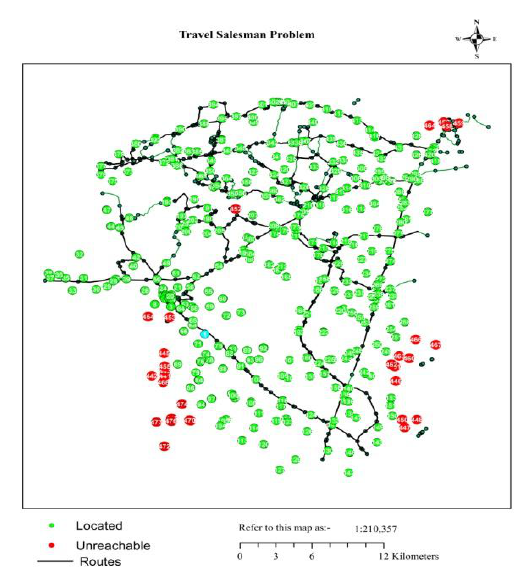
Figure 14. Optimal path based on travelling time map the school and road data of Bara tehsil. Optimal path analysis has been performed based on three parameters, i.e. population density, travelling distance and travelling time. A combined weight function is also given to find the optimal path. Many times there is a requirement to reach all the schools to distribute the food or any other material. This paper also gave the